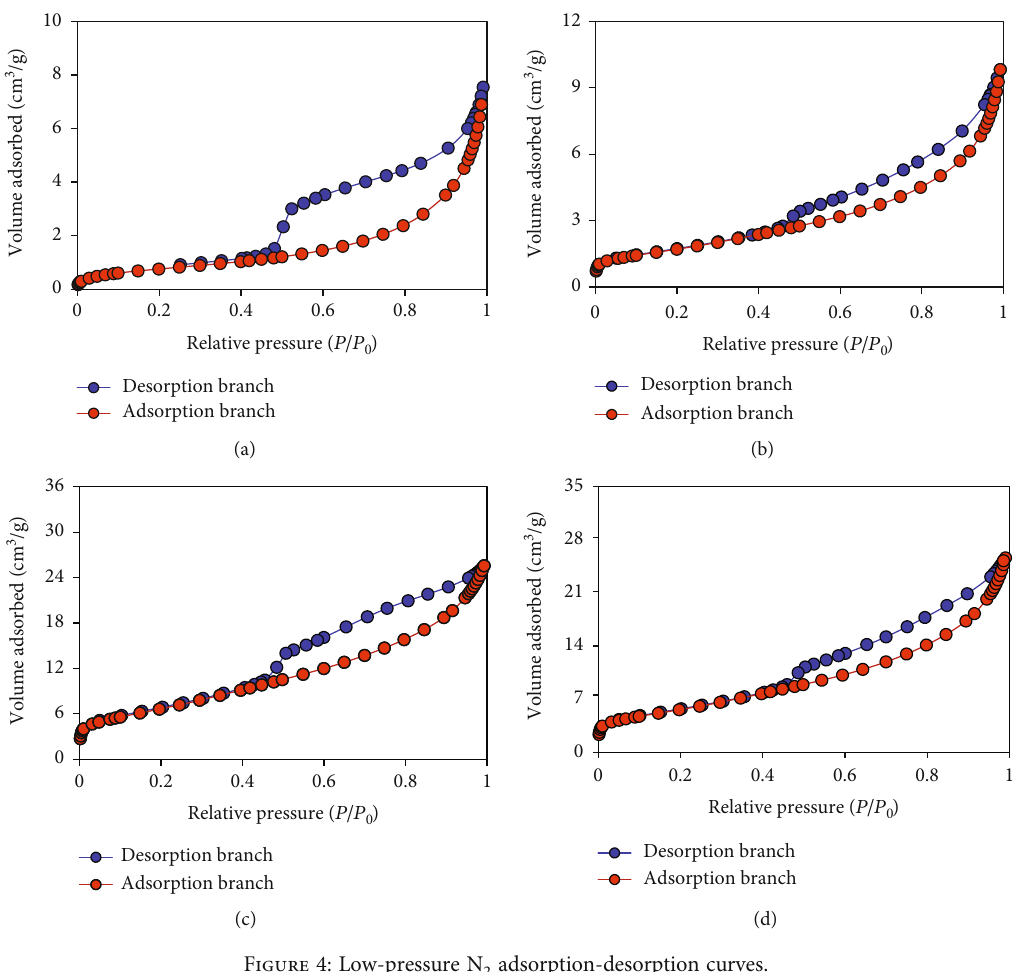
adsorption-desorption curves. 2